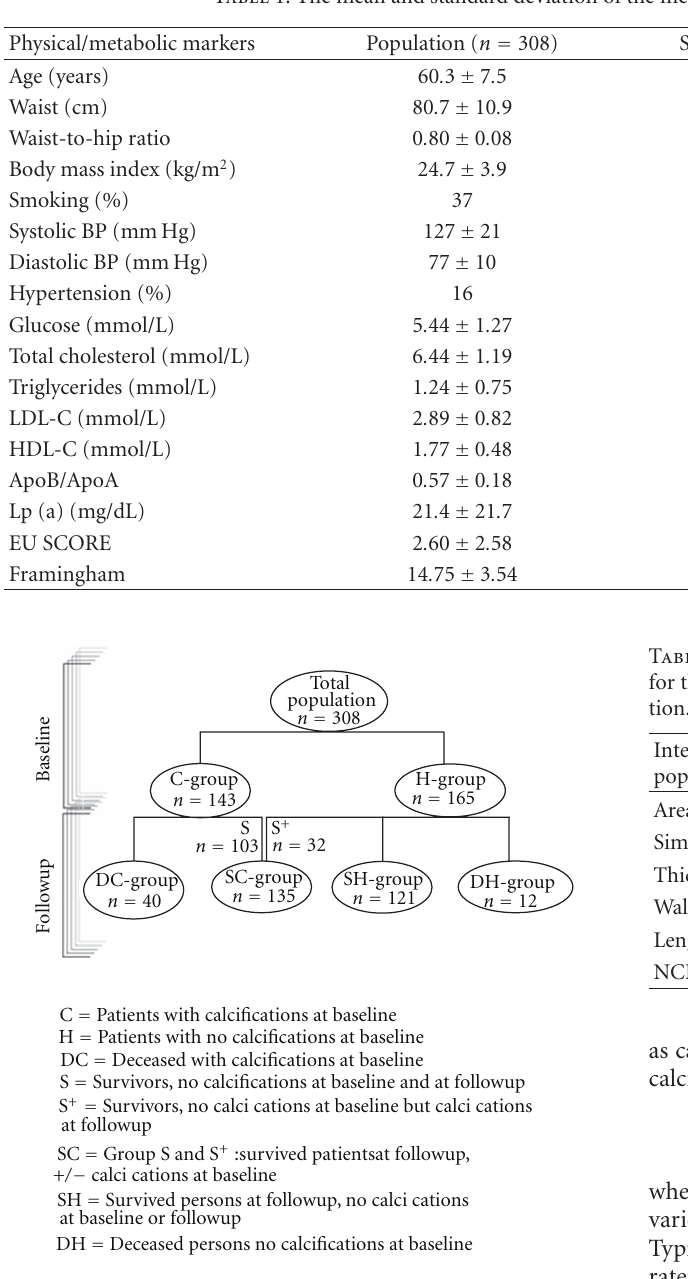
Figure 4: A schematic overview of the study population.